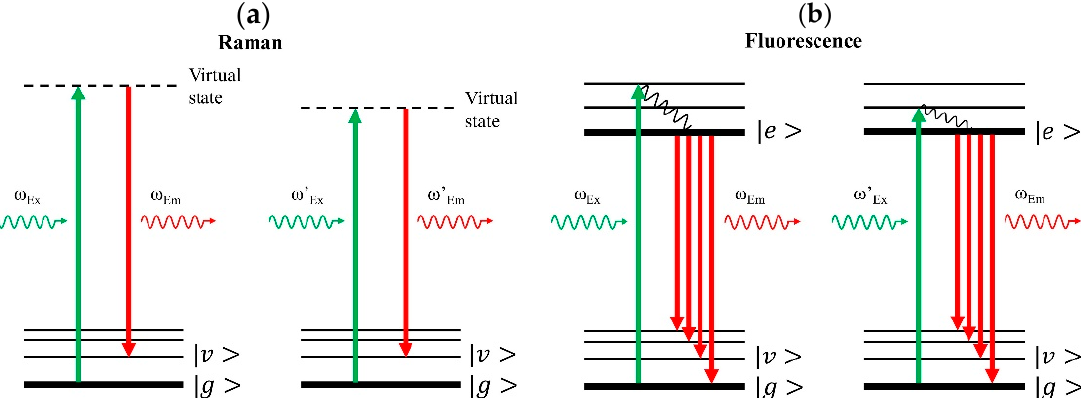
Figure 4. Energy diagram in Raman and fluorescence processes. | g > , | v > , and | e > denote ground state, vibrational state, and electronically excited state, respectively. The wavy lines show non-radiative transitions. Greater arrow length denotes higher frequency or higher photon energy, and vice versa. ( a ) Left panel. In Raman scattering, a molecule is pumped by a laser photon with frequency at ω Ex to a virtual state and then returns to one of its vibrational states, | v > , by emitting a signal photon with lower frequency at ω Em . The vibrational transition matches the frequency difference between input and output photons. Right panel. For the same vibrational transition, a modified, lower pump laser frequency, ω Ex ’, results in a corresponding signal emission at lower frequency, ω Em ’. Thus, the frequencies of Raman features vary as the laser excitation frequency changes. ( b ) Left panel. In the fluorescence process, the molecule is upconverted to its electronically excited state, | e > , and then decays to the lowest level of the excited state for subsequent fluorescence emission, ω Em . Right panel. A modified pump laser frequency, ω Ex ’, is relatively lower but still enough for the subsequent fluorescence emission. Fluorescence emission always starts from the lowest level of the excited state, and hence the frequency of fluorescence features will remain the same even if the input laser frequency varies. Consequently, slightly shifting the laser excitation frequency allows separation and detection of the pure Raman signal.